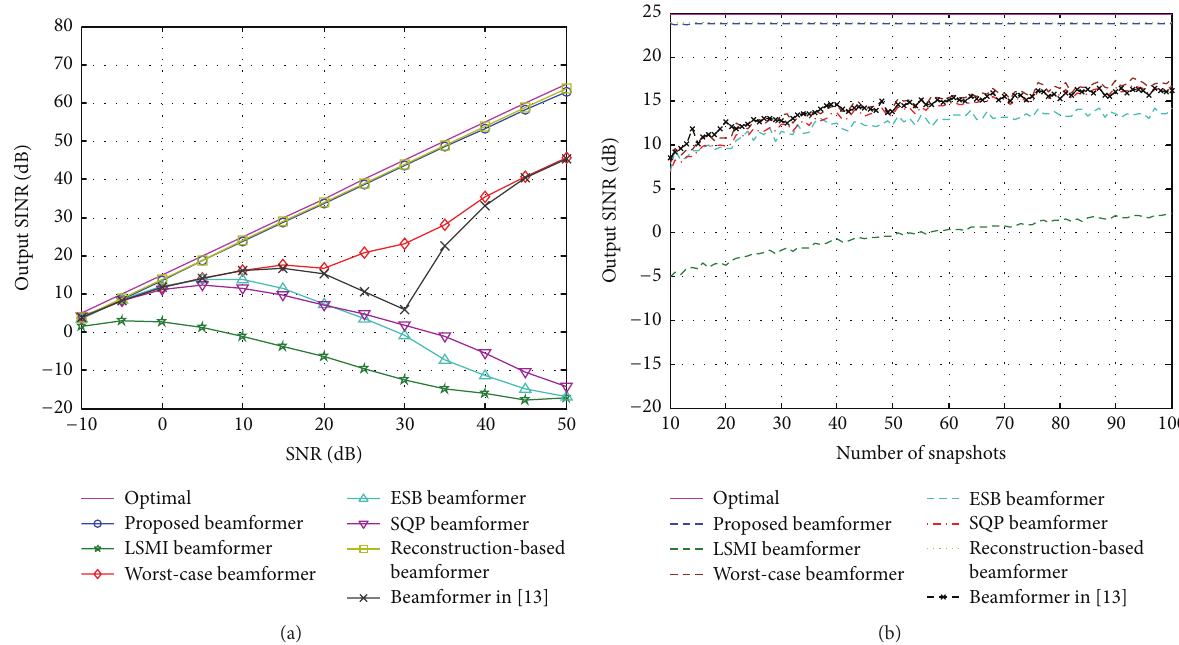
Figure 4: Performance of the beamformers for the case of ASV random error. (a) Output SINR versus SNR for training data size of 𝐾 = 60 and INR = 30 dB. (b) Output SINR versus number of snapshots for fixed SNR = 10 dB and INR = 30 dB.